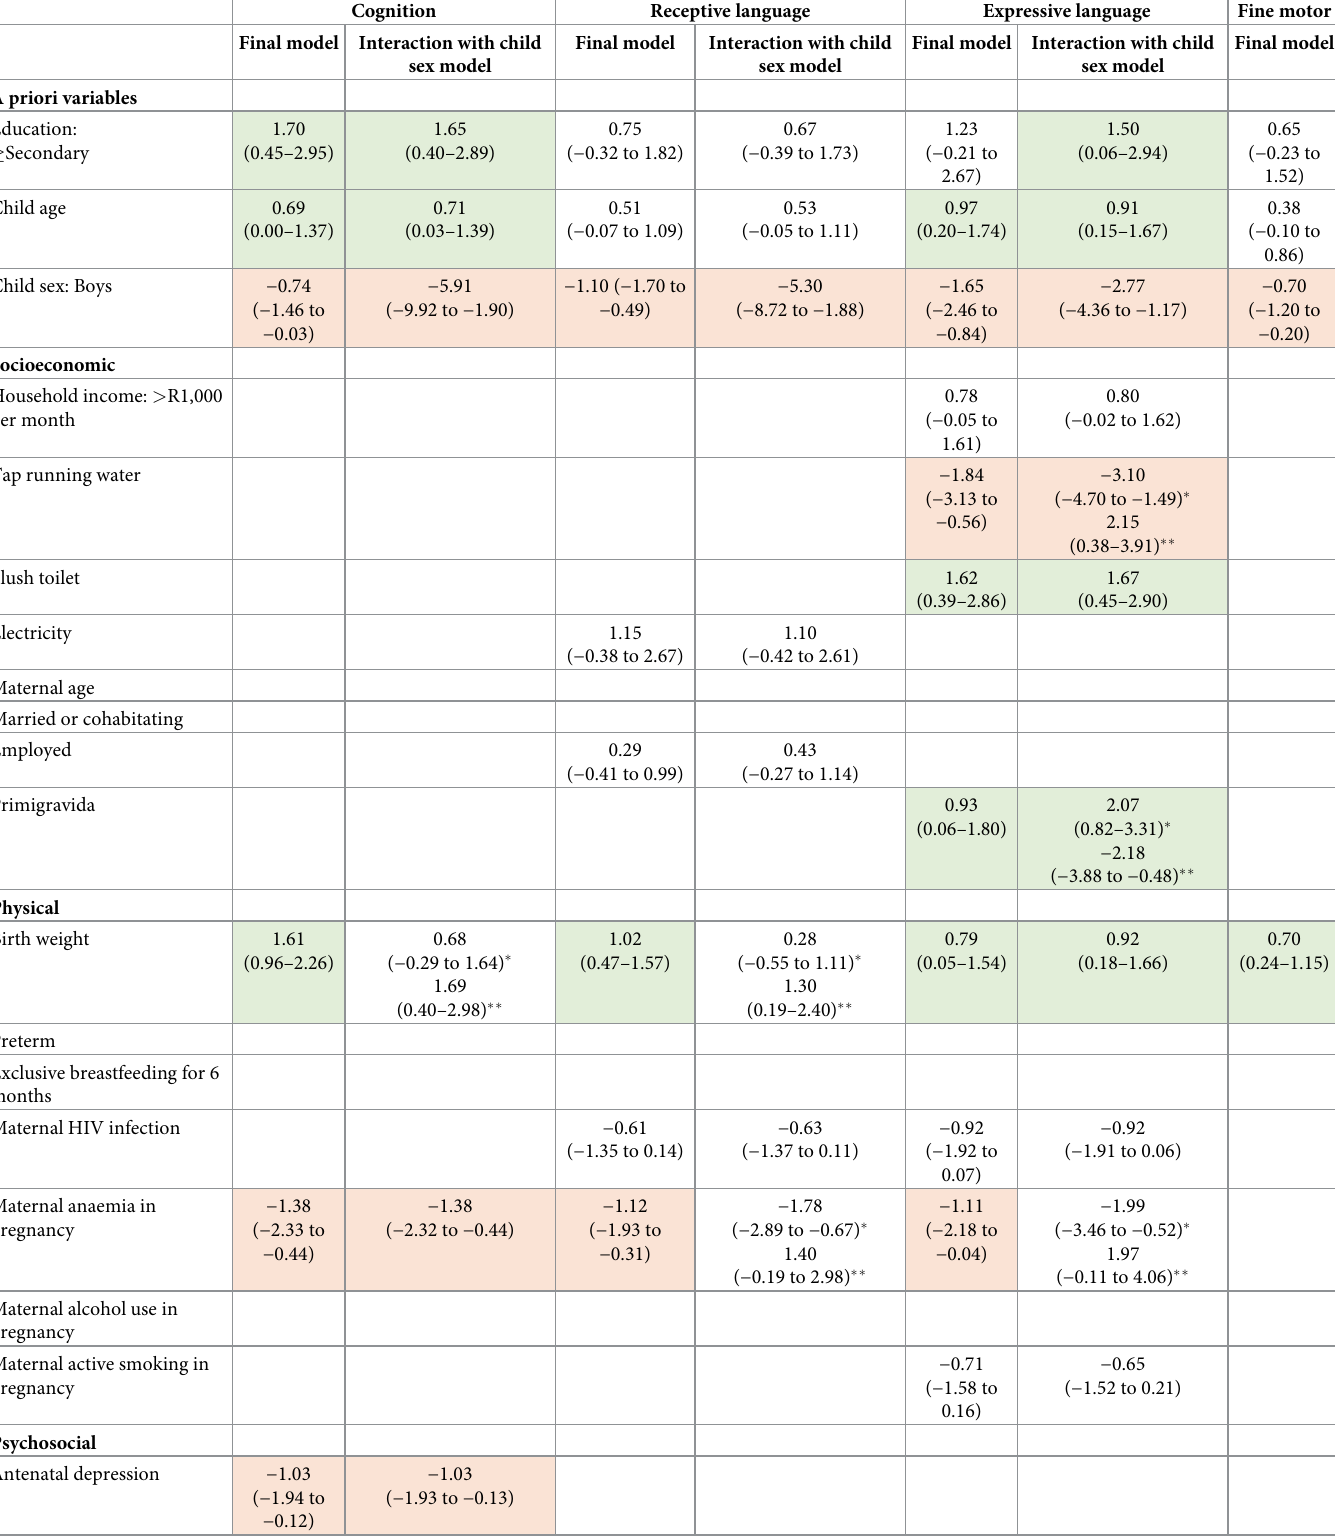
Table 3. Multivariable linear regression results demonstrating the association of risk and protective variables with developmental domain outcome for total raw scores and exploring interaction with child